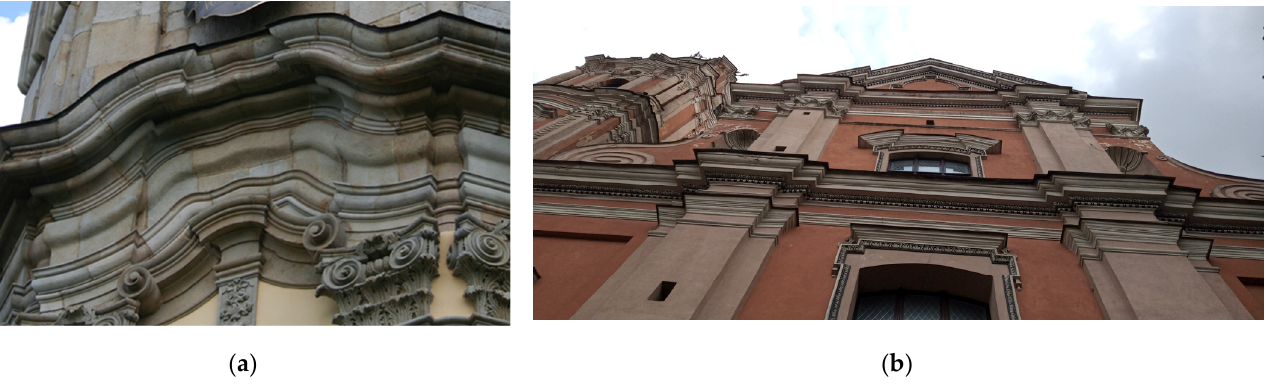
Figure 19. The Baroque entablature: ( a ) the late Baroque embattling entablature from the monastery church in Krzeszów; ( b ) the material and color separation of elements of the frieze above the supports in the entablature of early the Baroque church of All Saints in Vilnus (ca. 1660). Photos by author.